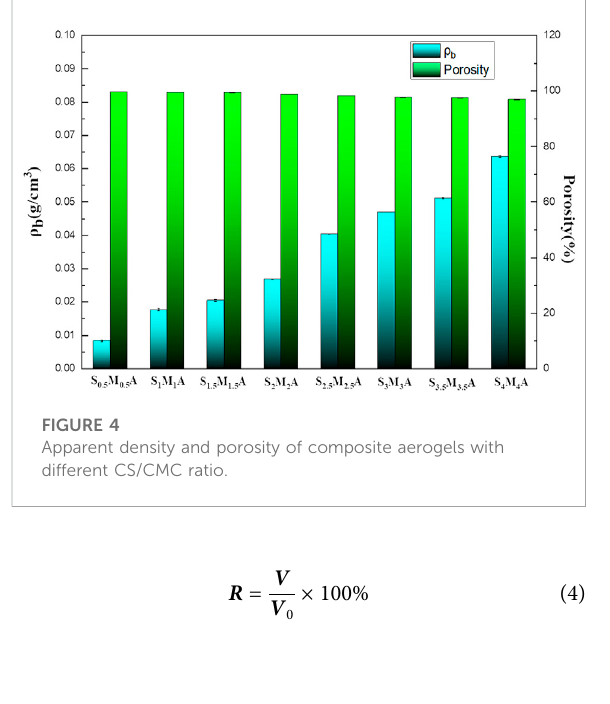
FIGURE 4 Apparent density and porosity of composite aerogels with different CS/CMC ratio.